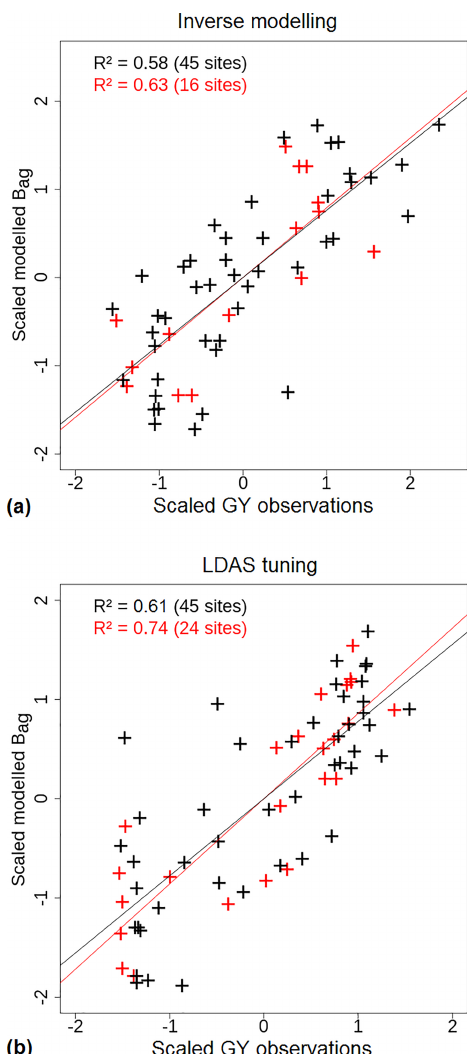
Figure 8. Temporal correlation between A s symbols) départements presenting significant positive correlations ( p value < 0.01) between simulated B ag X and GY and (red and black symbols) all 45 départements, and for (a) inverse modelling and (b) LDAS tuning.